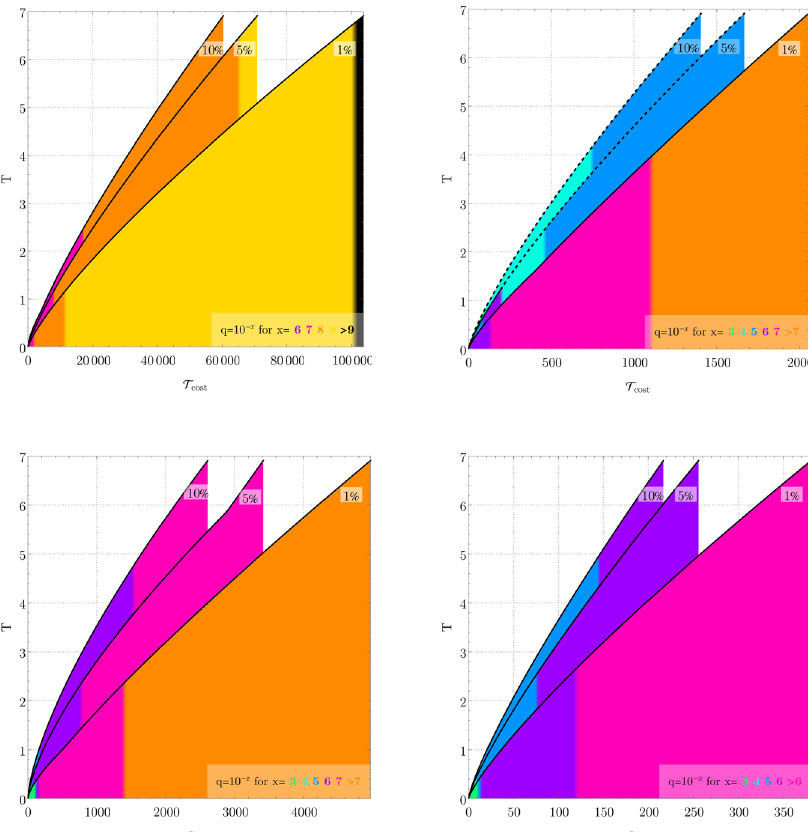
Fig. 2 Target simulation time T vs cost T cost for a 5 × 5 lattice FH Hamiltonian H FH from Supplementary Equation (139) using encoding of ref. 25 . Per- gate (left column) and per-time (right column) error models. The three lines represent 1, 5 and 10% Trotter error ϵ given in Supplementary Eq. (43), minimised over formula order p ∈ {1, 2, 4, 6}. Analytic Trotter bounds (top row), get δ 0 from Supplementary Corollaries 16 and 22 and Supplementary Theorem 20; numerical bounds (bottom row) by numerical extrapolation (see Supplementary Methods). Colours indicate achievable T for a given noise parameter q , keeping Trotter and depolarising errors below the 1, 5 or 10% bound, accordingly. E.g. the purple section of the bottom right 1% plot indicates that all T in that range needs q = 10 − 6 , with Trotter and decoherence error below 1%. Dashed lines indicate where error mitigation from ref. 25 can reduce the noise requirements. Additional lattice sizes and details shown in Supplementary Figs. 16 –